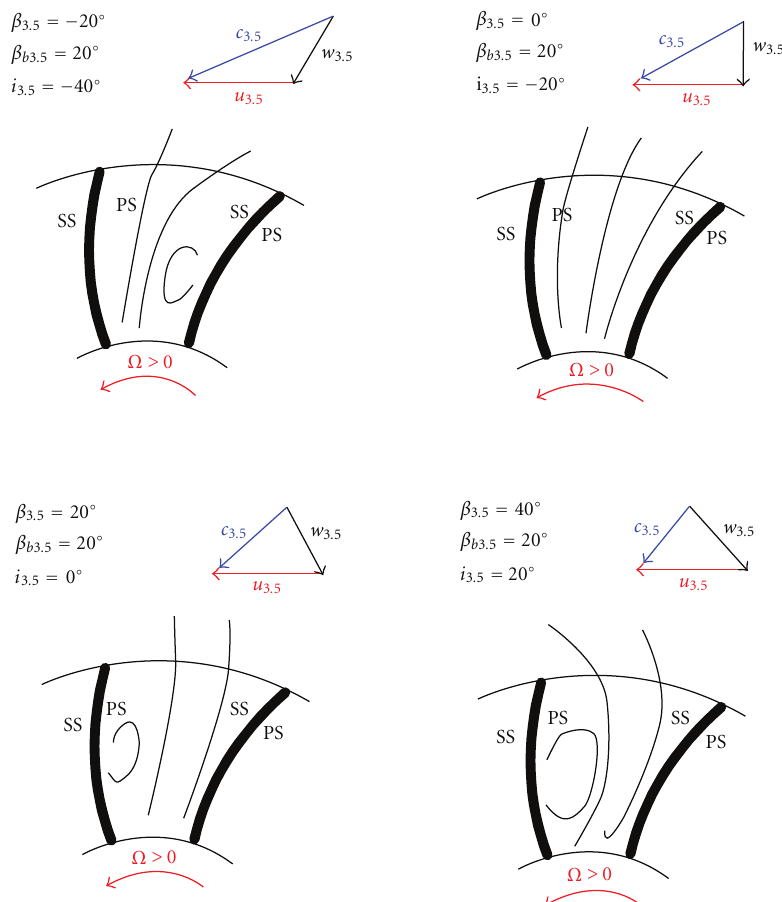
Figure 6: Backswept RFT/MFT inflow characteristics for di ff erent incidence